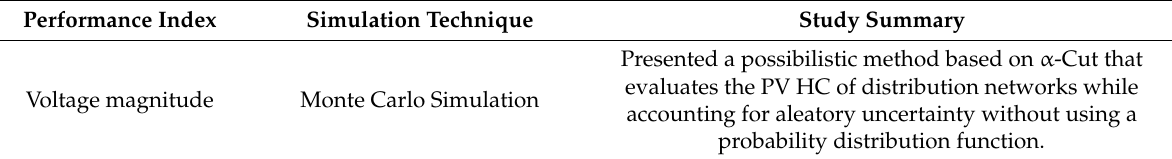
Table 4. Summary of studies that adopt the stochastic method for PV hosting capacity